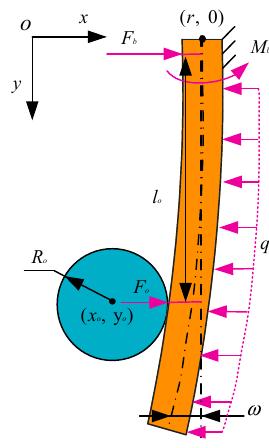
Figure 9. Force analysis of single pin.